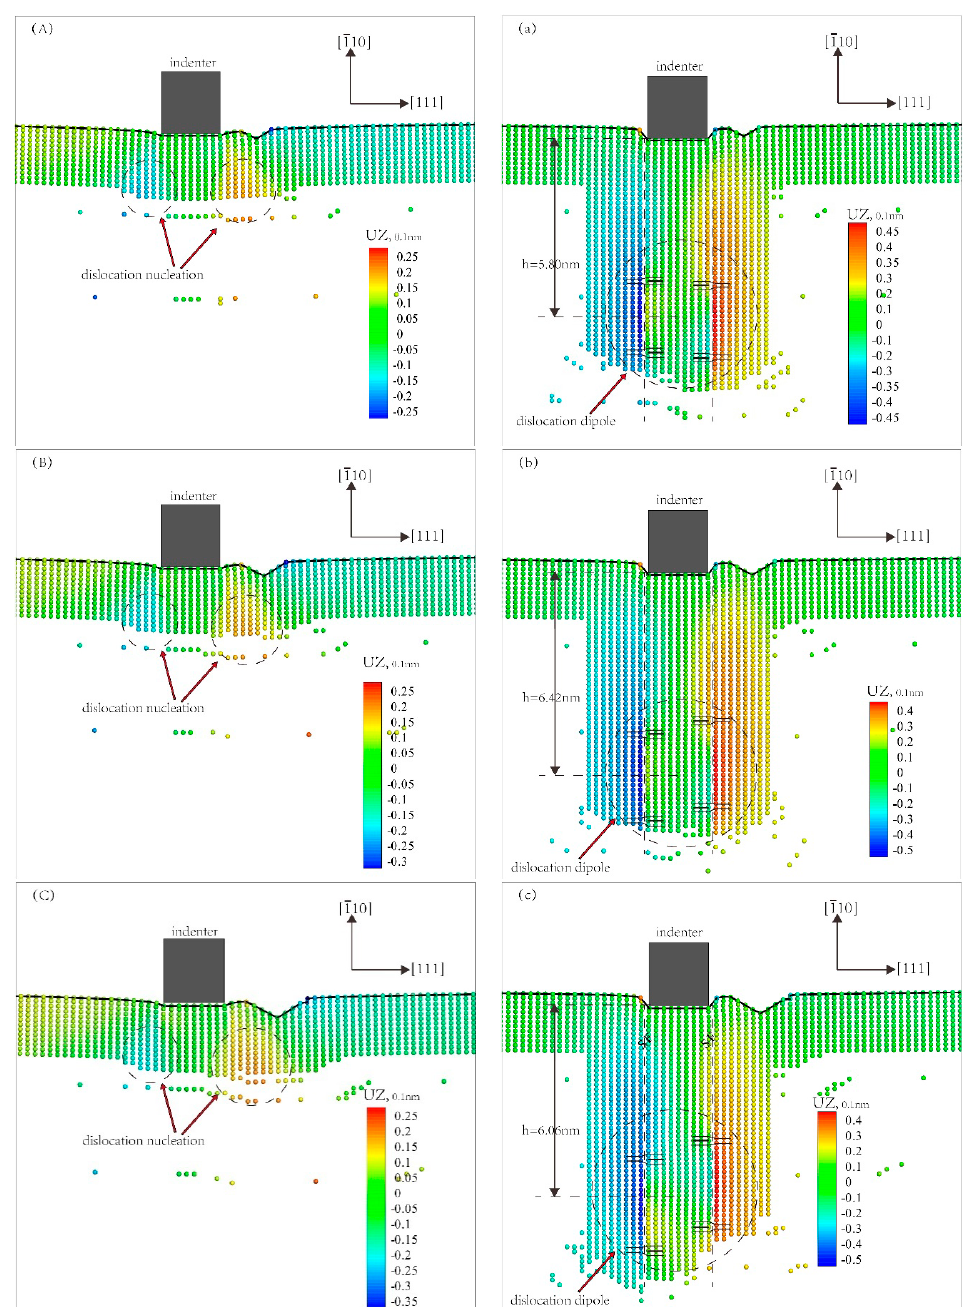
Figure 6. Snapshot of atoms under indenter and corresponding out-of-plane displacement plot, where UZ is atom displacement at out-of-plane: ( A ) 4 atom cavity at point C in Figure 2 (dislocation nucleation); ( a ) 4 atom cavity at load step 0.62 nm (dislocation emission); ( B ) 9 atom cavity at point A in Figure 2 (dislocation nucleation); ( b ) 9 atom cavity at load step 0.64 nm (dislocation emission); ( C ) 16 atom cavity at point B in Figure 2 (dislocation nucleation); ( c ) 16 atom cavity at load step 0.64 nm (dislocation emission).